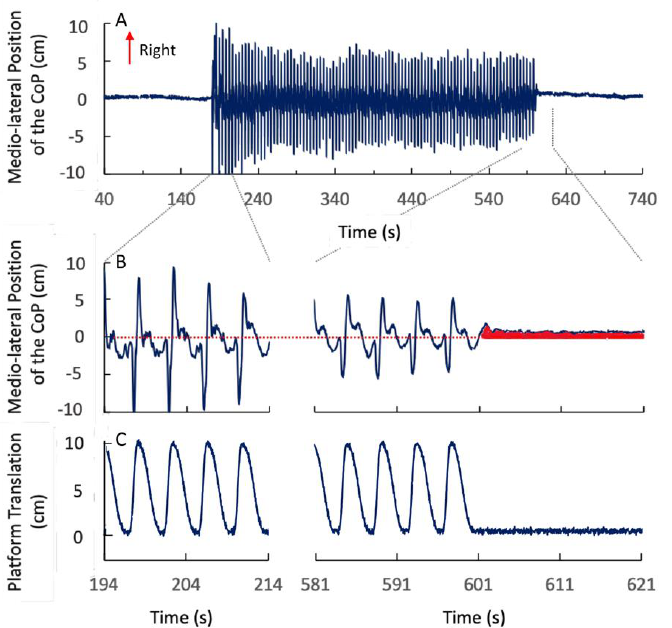
Figure 1. Medio-lateral (ML) centre of feet pressure (CoP) position in a representative participant during the fast right (FR) stimulation under the eyes closed condition (EC) ( A , B ) and platform translation trace ( C ). During the fast half-cycle to the right side, the CoP showed a large and fast ML displacement followed by a less ample and slower displacement during the slower half-cycle. In the central panel, the red area indicates the medio-lateral shift of the CoP post-stimulation, while the dotted red line indicates the pre-stimulation ML CoP position. Here and in the following Figures, right is